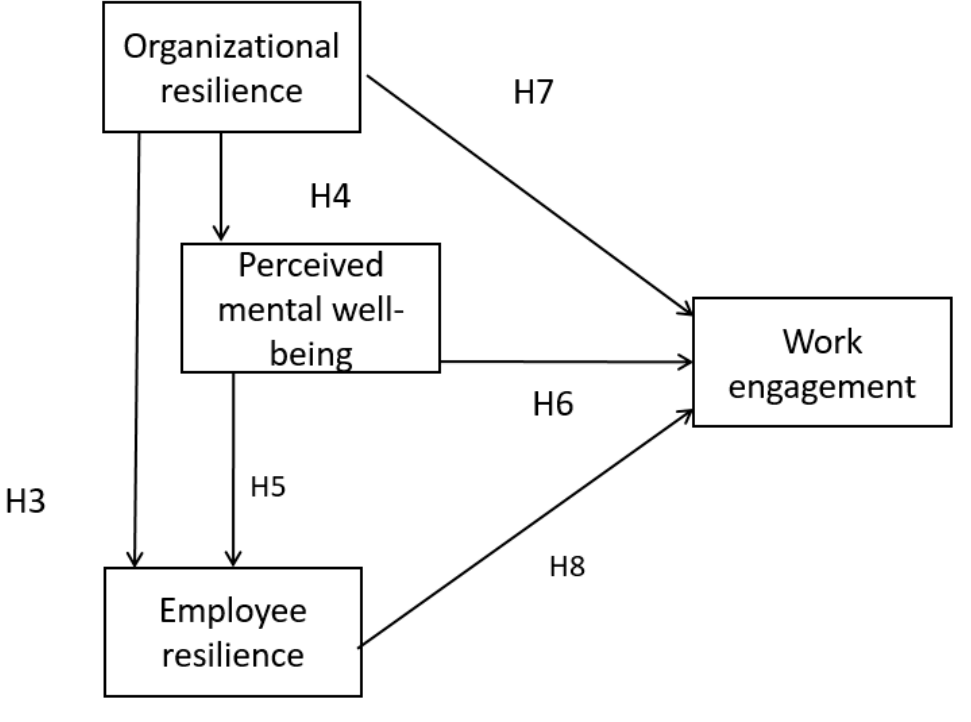
Figure 4. Mediation Analysis model.